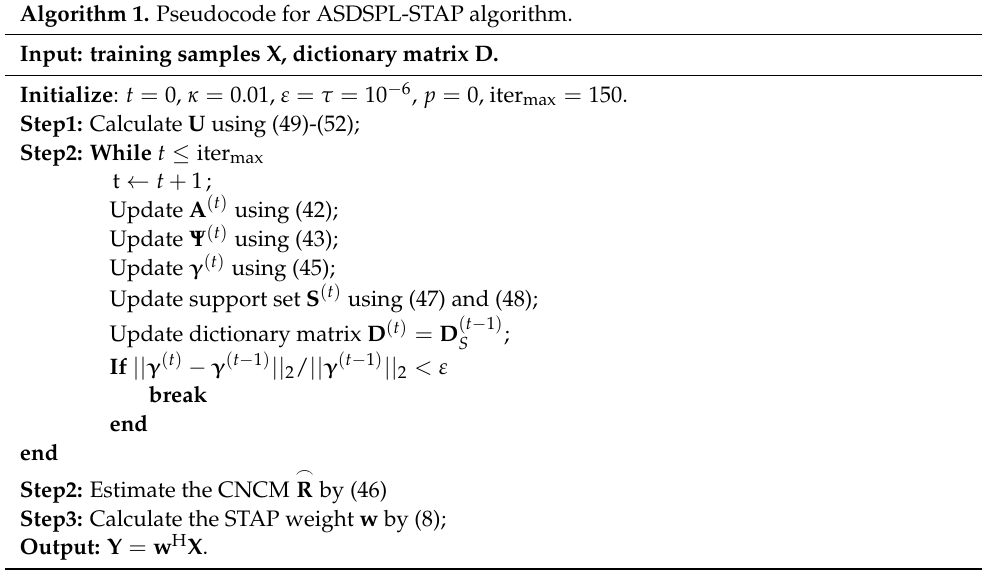
Algorithm 1. Pseudocode for ASDSPL-STAP algorithm.